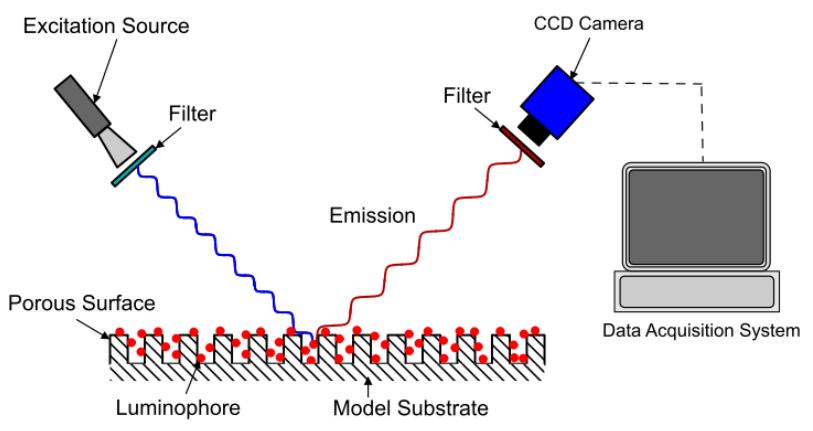
Figure 2. Porous based